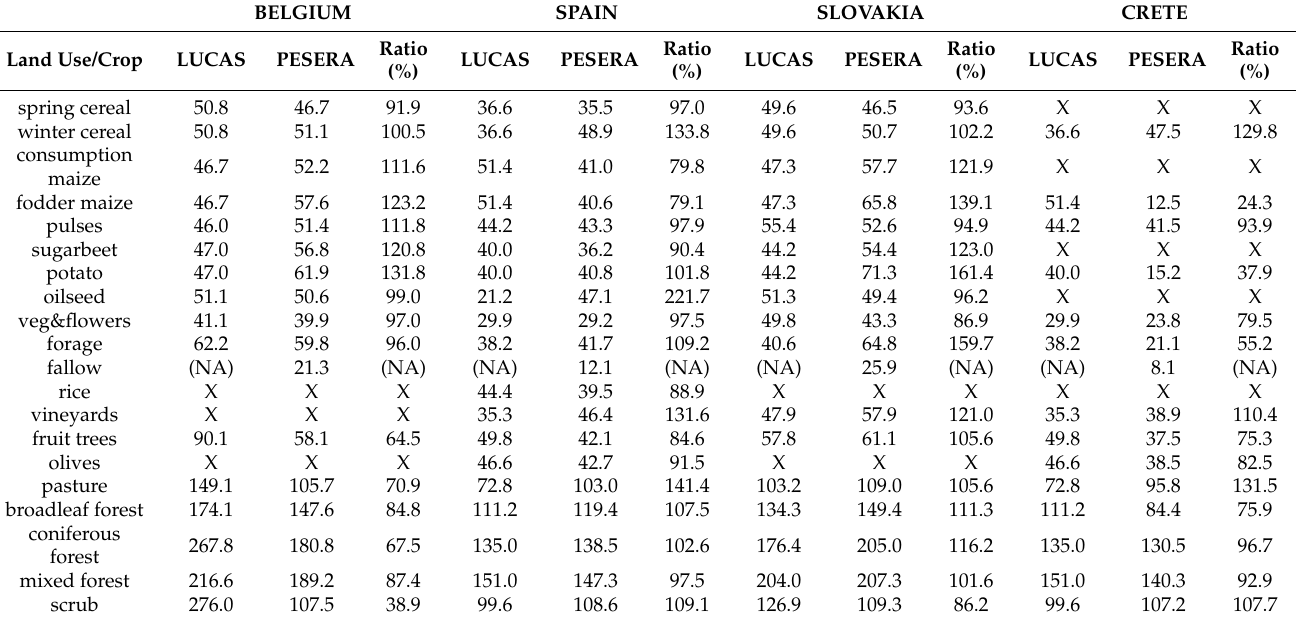
Table 4. Calibrated (PESERA baseline long-term results) versus observed (LUCAS database) results for SOC (t/ha) for three countries and the Greek island of Crete in different climate zones. Note: X = crop does not occur. NA = not